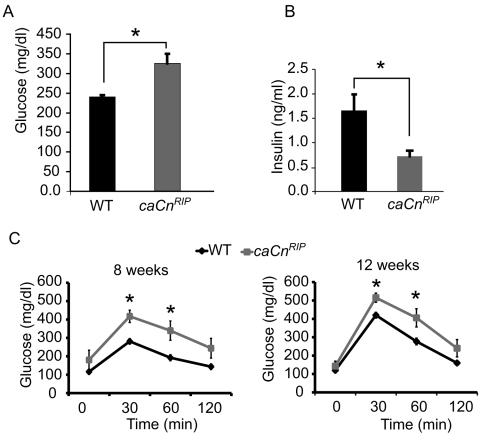
RIP-CnMut mice have higher fed serum blood glucose compared to control littermates.Serum glucose (A) and Insulin (B) concentrations in non-fasting 2–3 month old caCnRIP mice (n = 5) and control littermates (n = 8). C. Intraperitoneal glucose tolerance tests in 8 and 12-week old caCnRIP mice (n = 7) and control littermate (n = 4) males as indicated (left and right panels; n = 4). Results are expressed as mean ± SEM. * p<0.05.